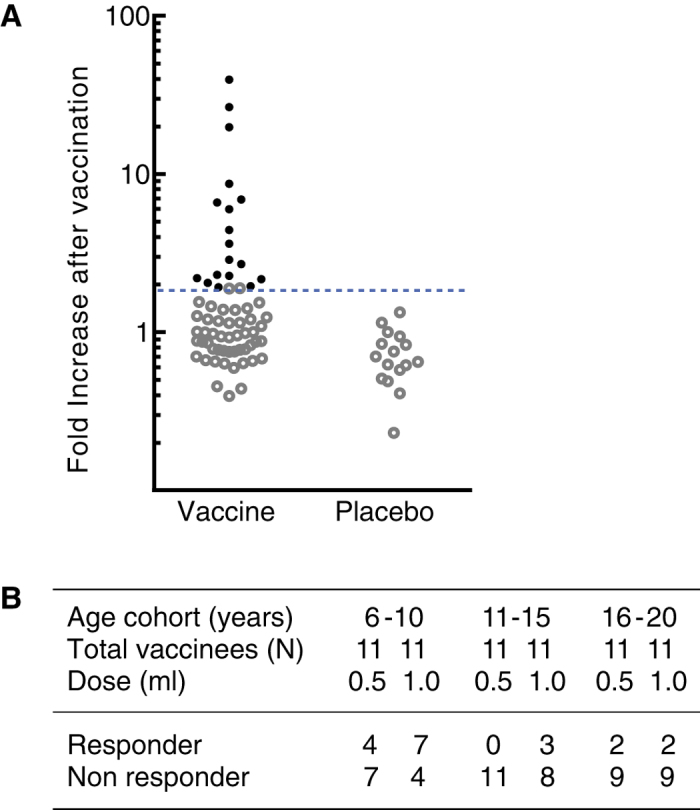
Distribution of the fold increase in antibody titres after two vaccinations.(A) Filled circles (●) and open circles (○) denote individual volunteers designated as responders or non responders, respectively in the vaccine and placebo groups. Dotted line represents the cutoff level in fold increase of antibody titre after vaccination for grouping according to immune response based on the upper limit of the 99% CI of fold increase in the placebo group. (B) The table summarises the proportion of vaccinees designated as responder and non responder for each age cohort and vaccine dose [half- (0.5 ml) or full-dose (1.0 ml)].